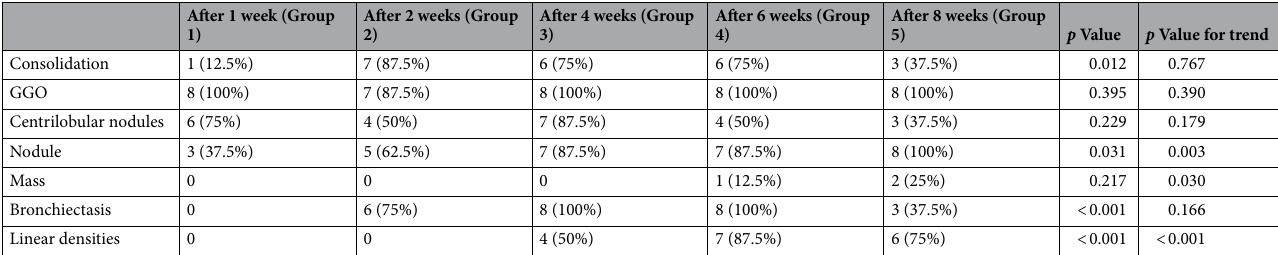
Table 1. CT findings and changes according to the groups. GGO, ground glass opacity.